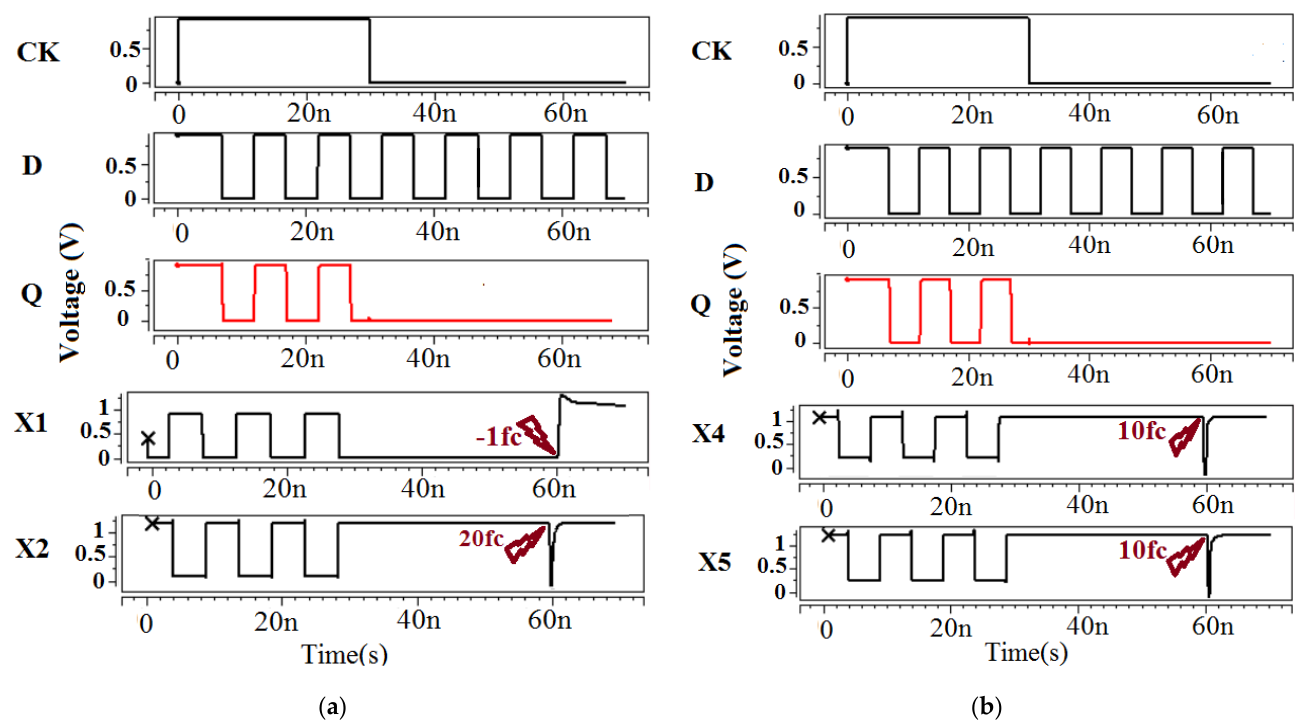
Figure 5. Test results when the output is “0” during the holding time: ( a ) negative and positive SEU injection to “X1” and “X2” nodes, respectively; ( b ) positive SEU injection to “X4” and “X5” nodes, respectively.